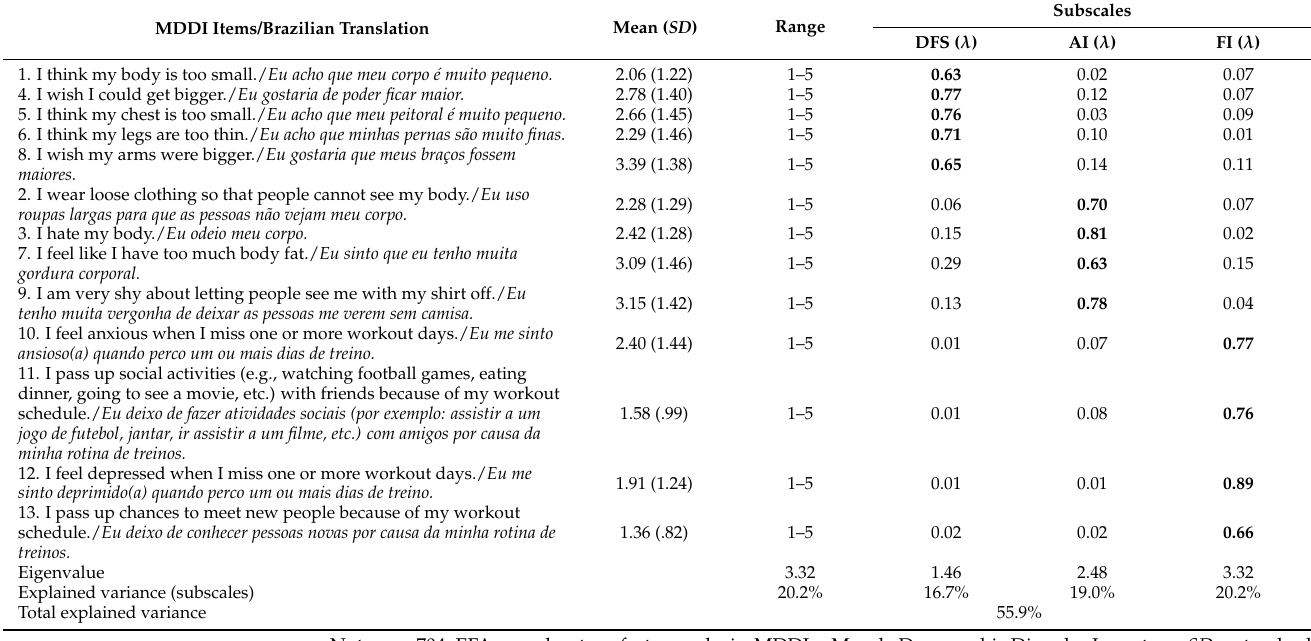
Table 3. Descriptive statistics and factor loadings for EFA of the Muscle Dysmorphic Disorder Inventory (MDDI) for Brazilian cisgender gay and bisexual adult